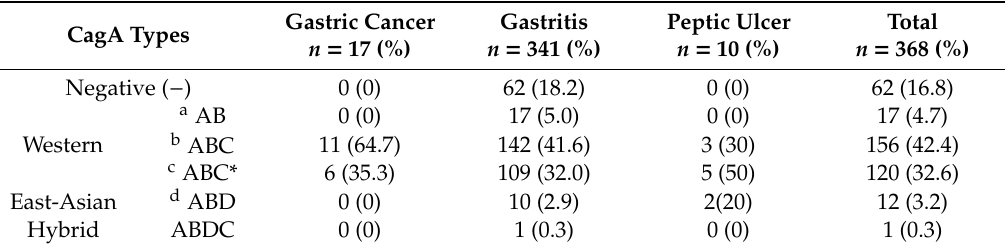
Table 1. The CagA types based on